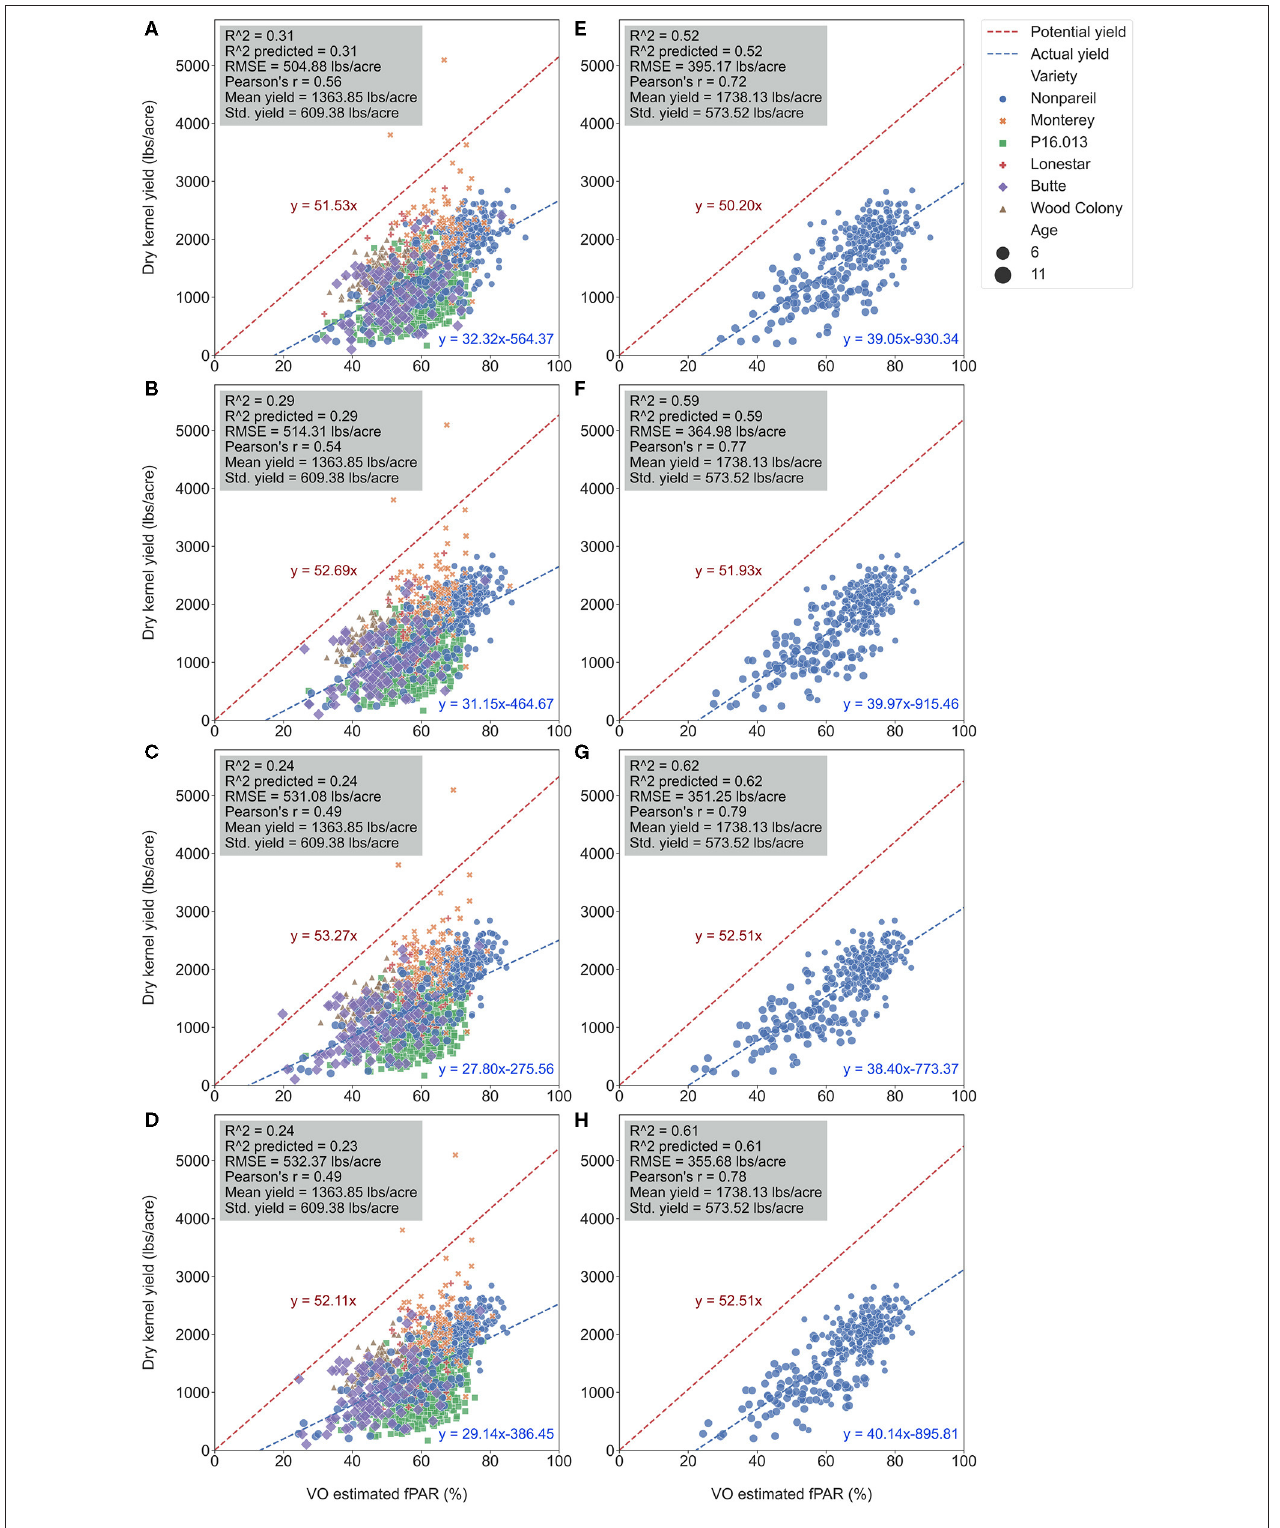
FIGURE 10 | Comparison of accuracies of actual almond yield explained by Virtual Orchard (VO) estimated canopy fractional PAR (fPAR) over the season with all varieties: May 28 (A) , June 26 (B) , July 26 (C) , and August 7 (D) ; and ‘Nonpareil’ only: May 28 (E) , June 26 (F) , July 26 (G) , and August 7 (H) at the per-tree level in 2019. The potential almond yield (57.9 lb acre − 1 for all varieties; 57.7 lb acre − 1 for ‘Nonpareil’ only) was based on the results reported by Jin et al. (2020) using a lightbar.